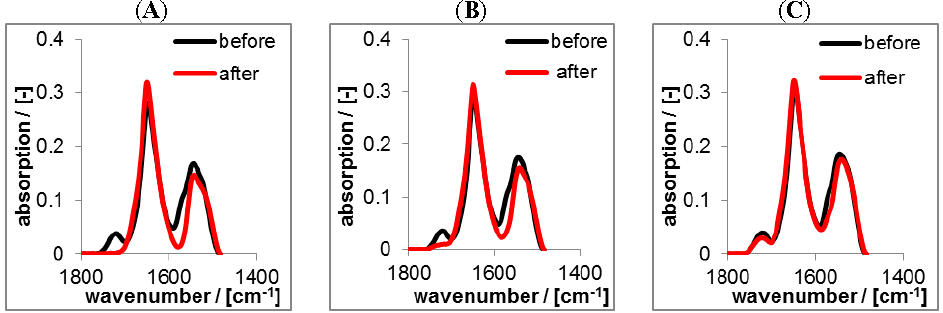
Figure 12. ATR-FTIR spectra of solution casted RIF-loaded PEC1.2 films prepared at pH = 2 before and after rinsing (2 days) with TRIS at pH = 10 ( A ); HEPES at pH = 7 ( B ) and CIT at pH = 4 ( C ) in the dry state, respectively.